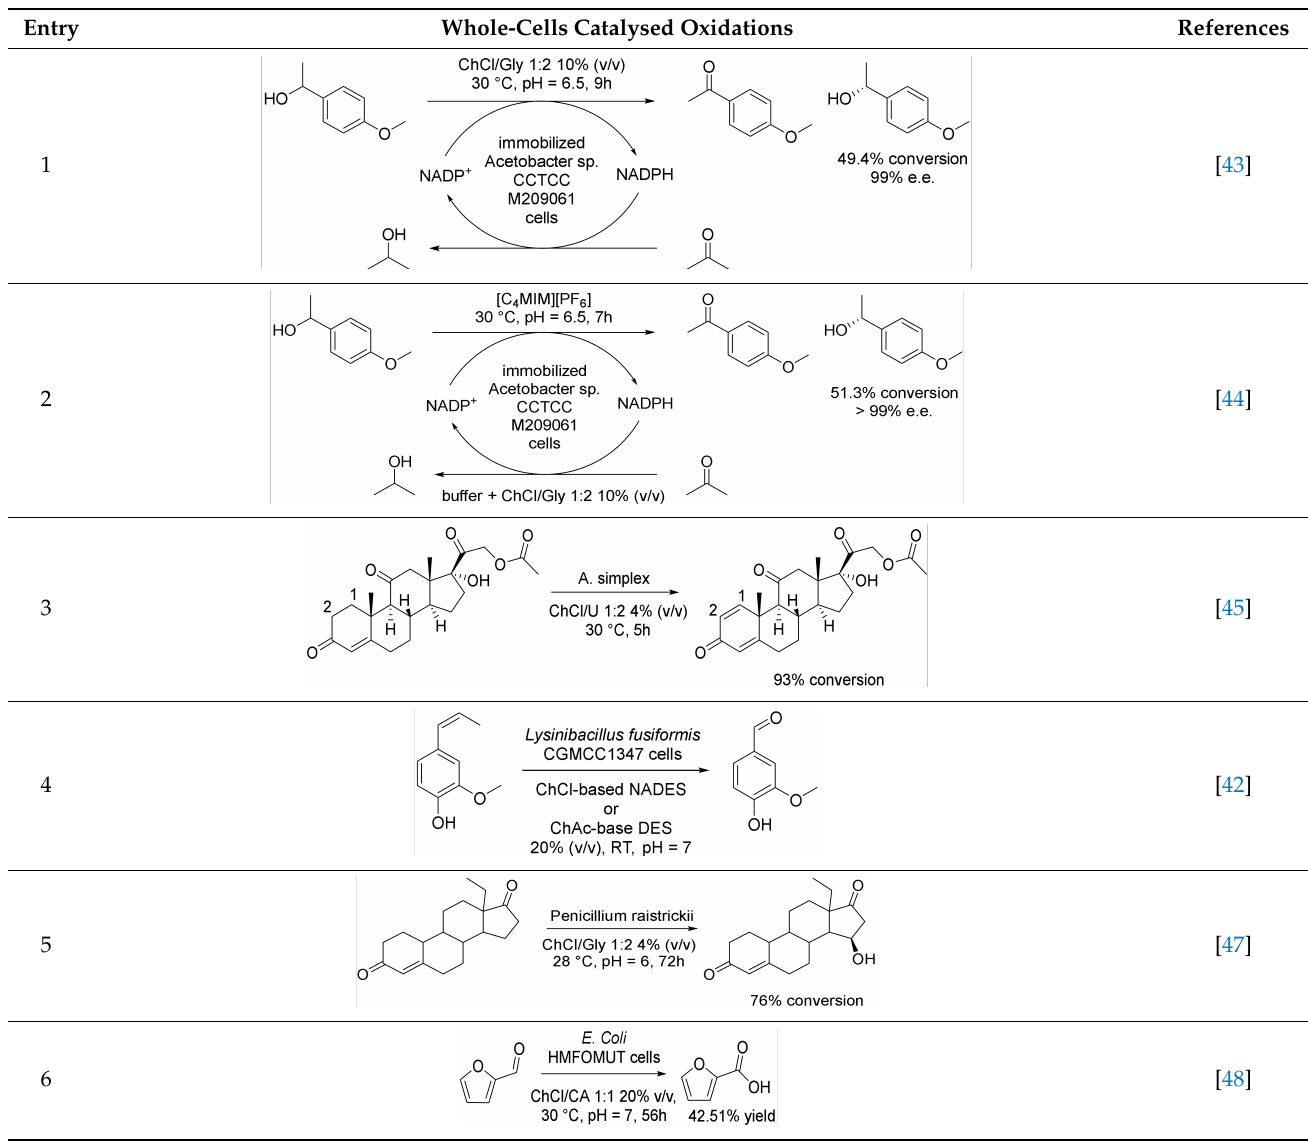
Table 4. Whole-cells catalysed